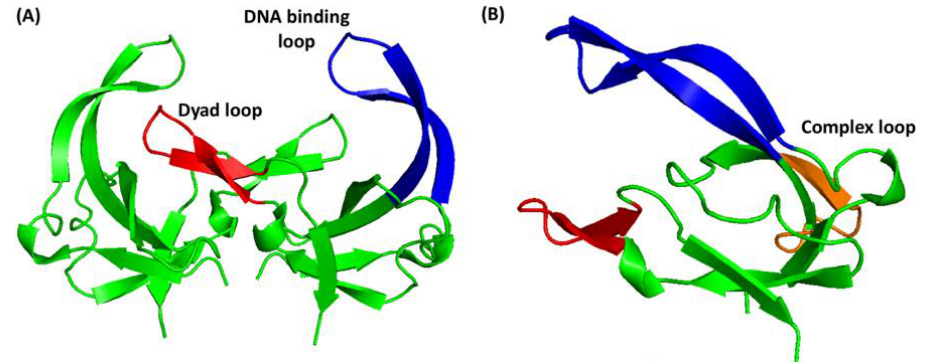
Figure 1. Ribbon diagram of gVp structure as determined using solution NMR [16]. ( A ) The gVp dimer with a symmetry axis parallel to the plane of illustration. ( B ) View of the gVp monomer rotated around the Y-axis on panel A. The three major loops, the dyad loop (red), the complex loop (orange), and the DNA binding loop (blue), are indicated. The images were reproduced from data stored in the Protein Data Bank, pdb id 2GVB, using the software PyMOL [24].